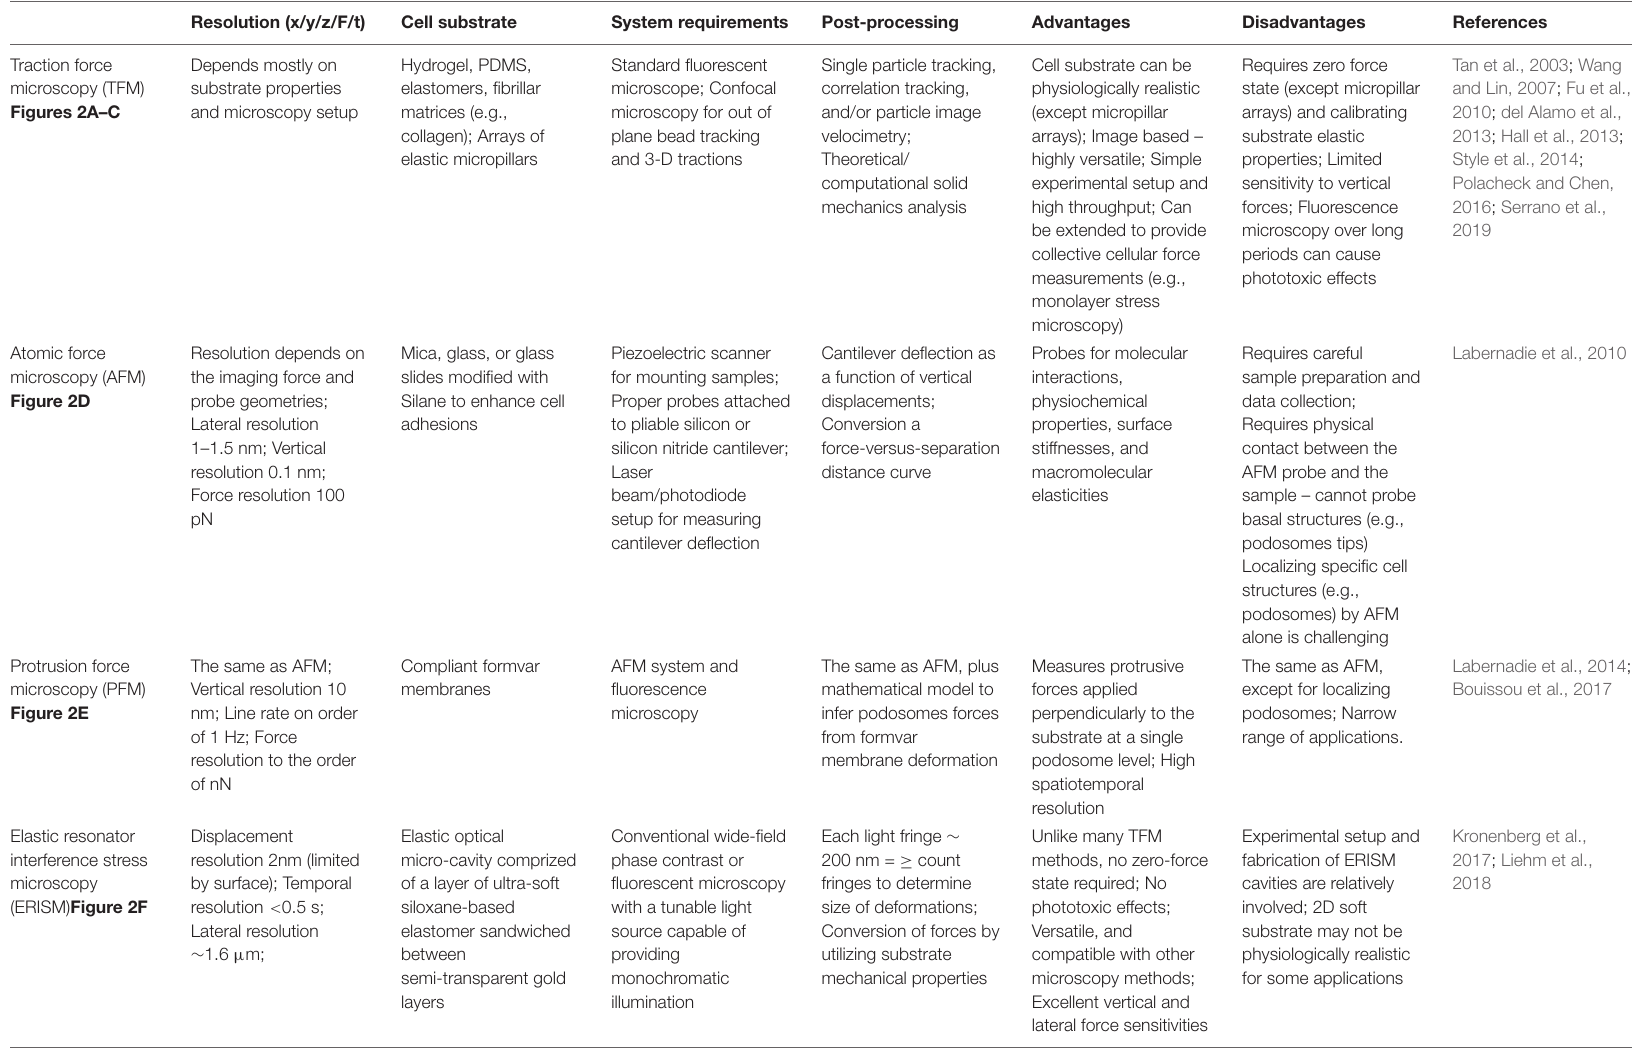
TABLE 1 | Summary of cellular force measurement